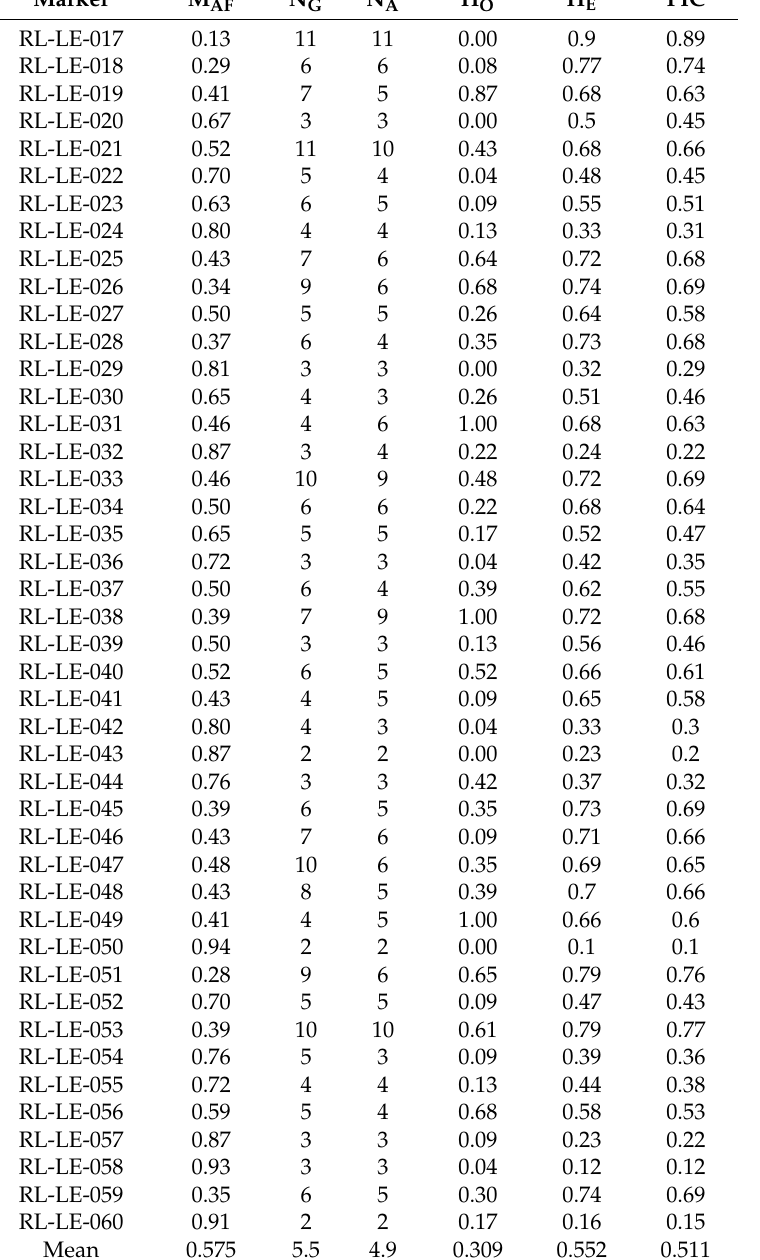
Table 3. Diversity statistics from each primer used for screening 23 cultivars of shiitake mushroom ( Lentinula edodes